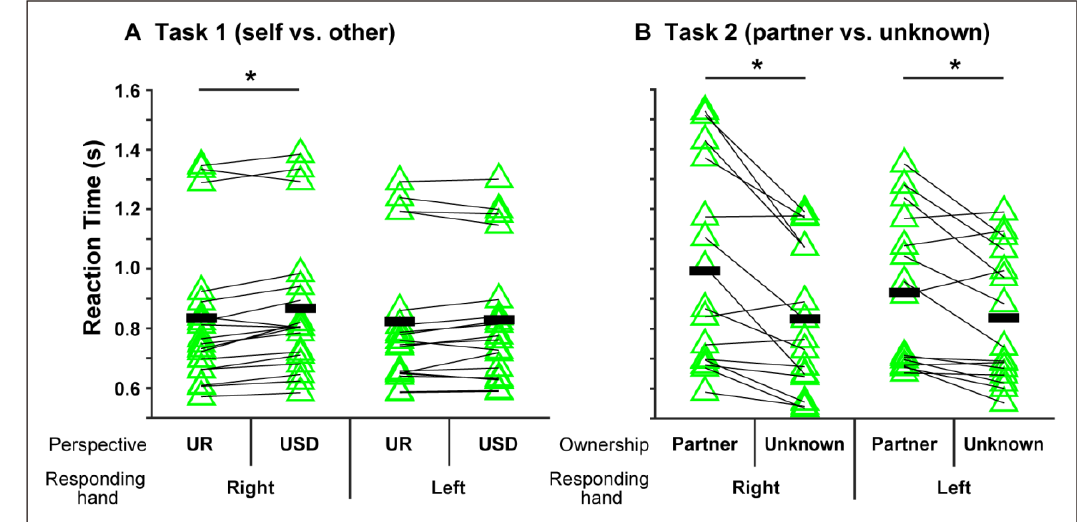
Figure 2. Mean reaction time (RT) in ( A ) Task 1 (self vs. other) and ( B ) Task 2 (partner vs. unknown). UR and USD denote upright and upside-down images, respectively. Black bars indicate mean values in each condition. * p < 0.05.